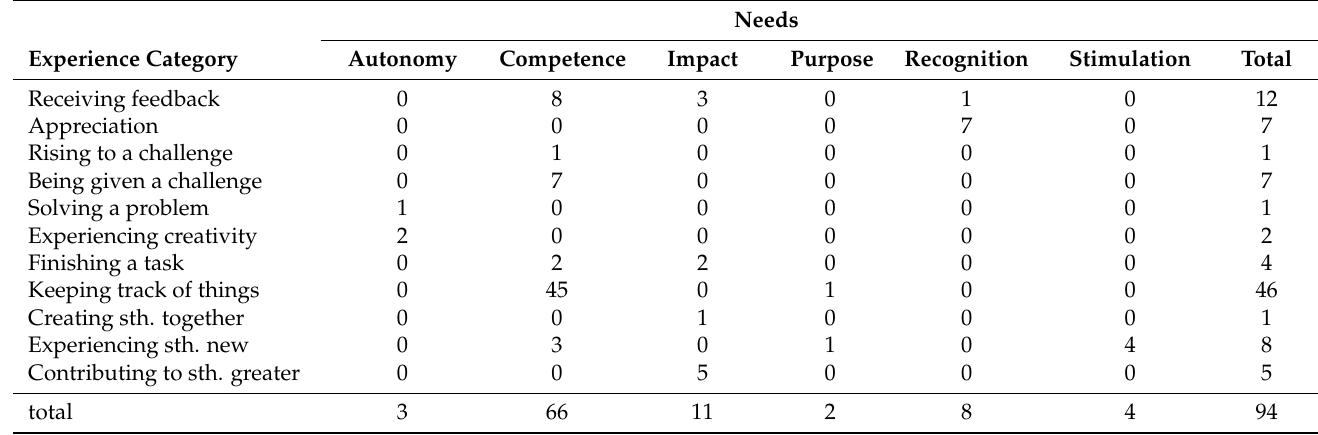
Table 9. Contingency table of assigned experience categories and needs in Study